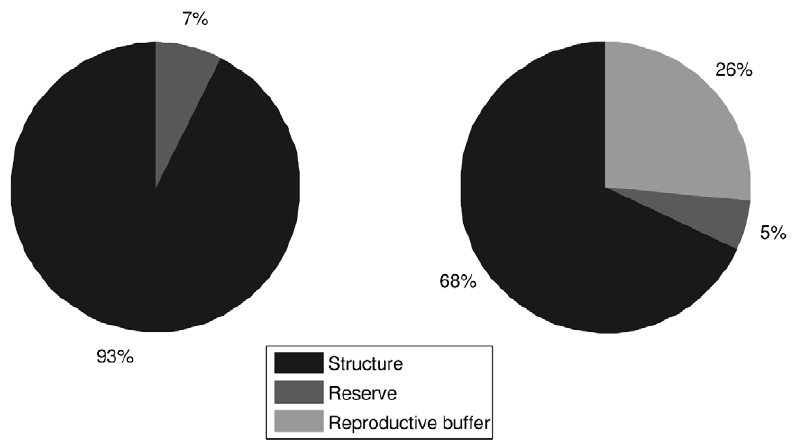
Figure 10. Relative contributions of structure, reserve and reproductive buffer to body weight of 220 cm long PBT prior to the beginning of the reproductive season (left panel; body weight 309 kg; condition index 2.9) and after the reproductive season (right panel; body weight 228 kg; condition index 2.1).